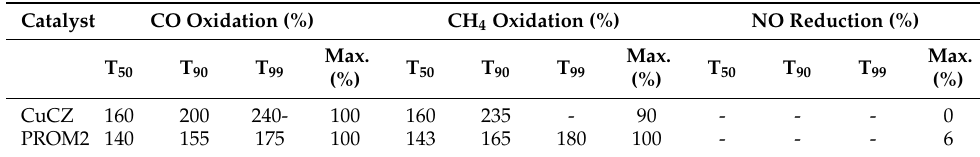
Table 6. Comparison of tested catalysts for the abatement of CO, CH 4 , NO at lean-burn conditions ( λ =